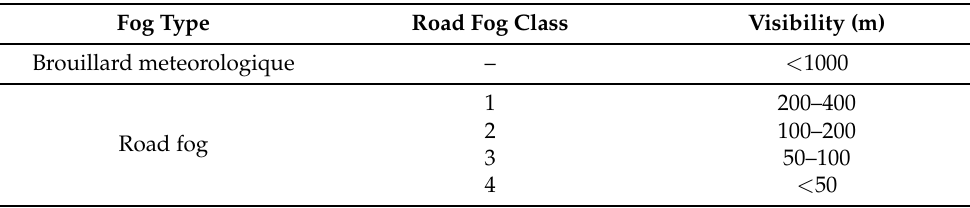
Table 2. Different fog classes according to French standard NF P 99-320